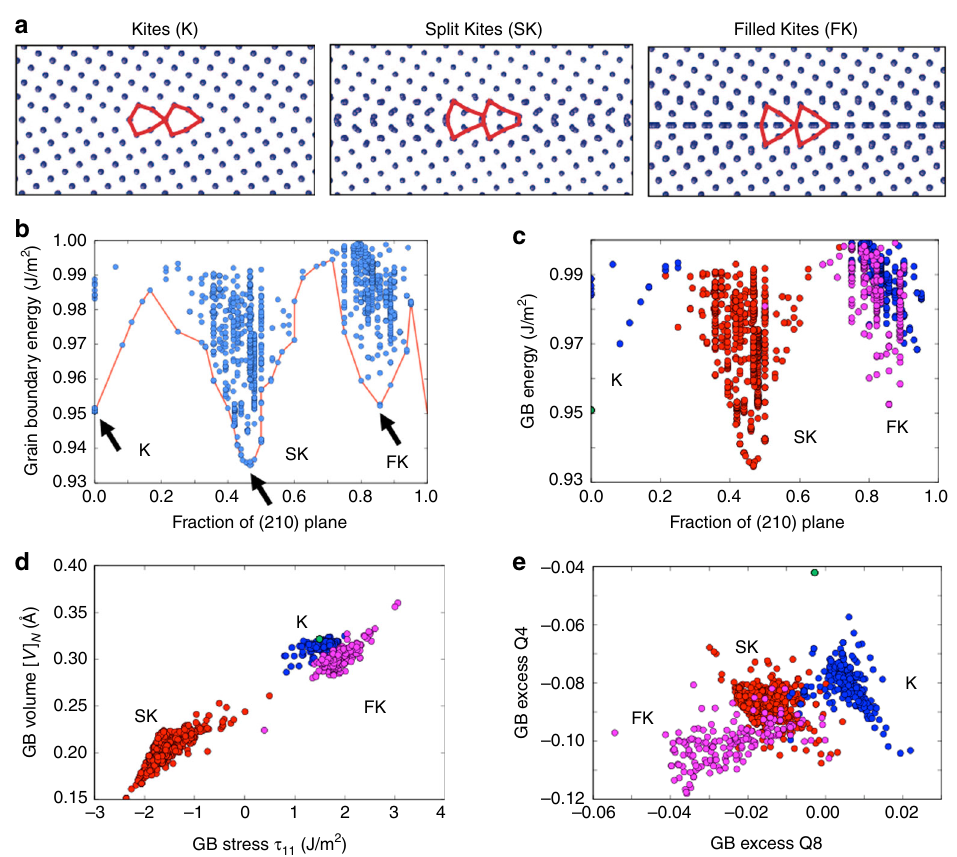
Fig. 2 Evolutionary search and clustering analysis identify GB phases. The evolutionary search and clustering analysis identify three grain boundary phases of Σ 5(210)[001]. The evolutionary algorithm explores different atomic densities and identi fi es multiple grain boundary phases: a Kites, Split Kites, and Filled Kites. The three phases correspond to the energy minima as a function of number of atoms. b Energy of grain boundary con fi gurations generated by the evolutionary search as a function of number of atoms. d , e The generated structures are automatically clustered into three grain boundary phases according to similarities in their excess properties. c Grain boundary energy plot same as in b with data points colored according to the